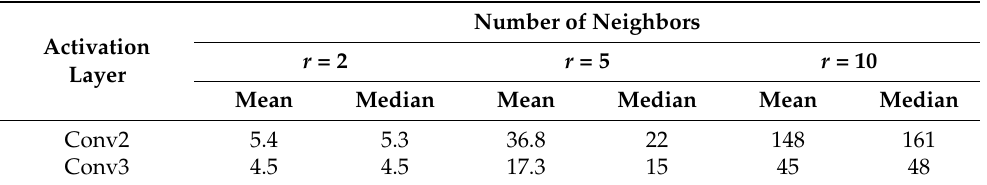
Table 3. Number of neighbors for various neighborhood radii using the MST criterion on the NiN instructor